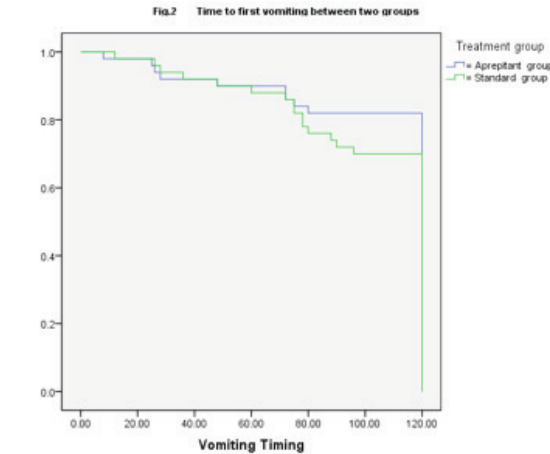
Figure 1: Comparison of the complete response rate between the two groups